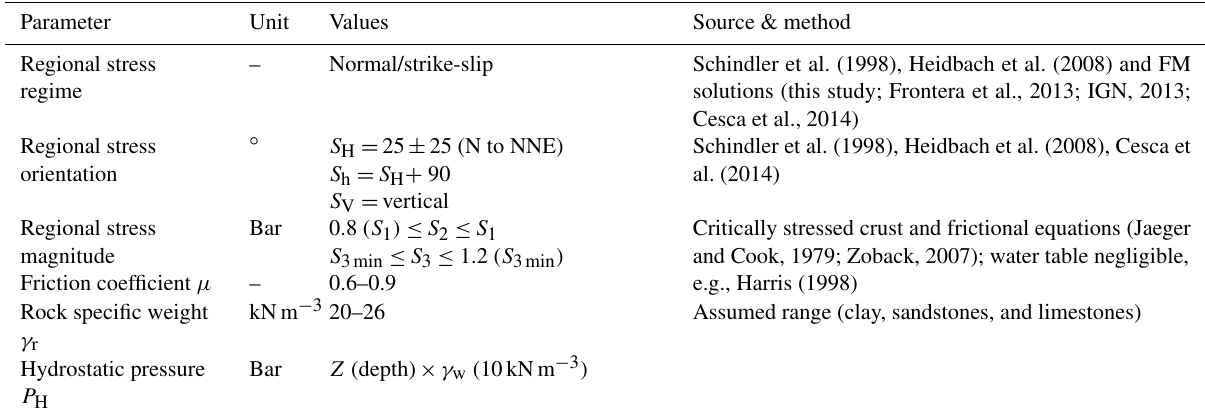
Table C1. Needed parameters for the calculation of CPP on each NP and their chosen ranges in addition to the FM solution and their depths (refer to Table A1).